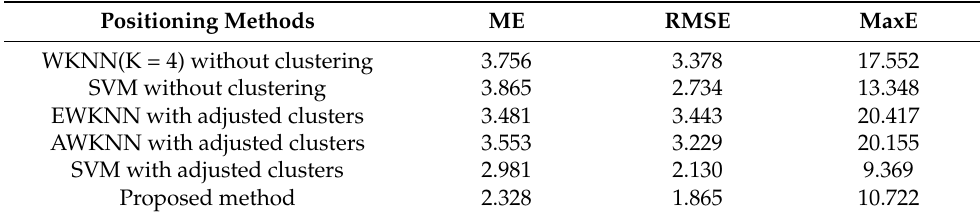
Table 3. Statistics of positioning errors of six methods (m).